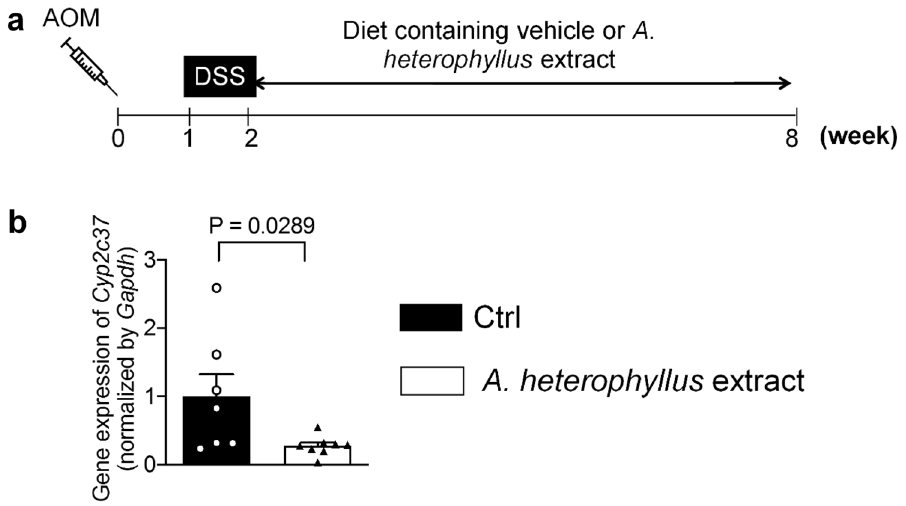
Figure 4. qRT-PCR evaluation of the Cyp2c37 gene expression in vivo . ( a ) Scheme of animal experiment. ( b ) qRT-PCR analysis of Cyp2c37 gene expression in colon tissues. The results are expressed as the mean ± SEM, n = 11 mice in Ctrl group and n = 10 mice in the A. heterophyllus group. Ctrl, vehicle control.